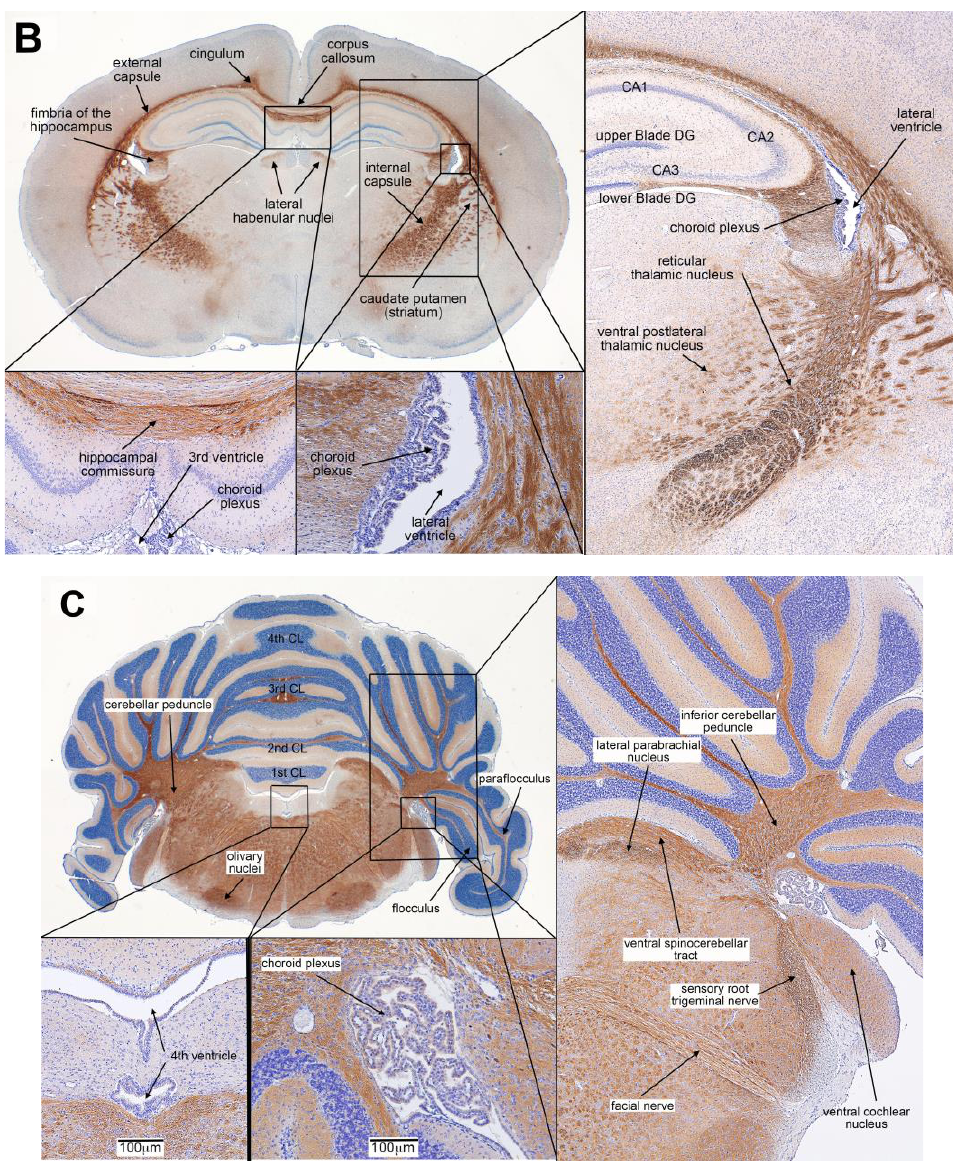
Figure 2. ( A ). Time course of Biotin-PGA uptake and distribution in the PND23 rat brain, immunostained for B-PGA (brown) and hematoxylin (blue/purple). ( B ). Regional distribution of B-PGA in the PND23 cerebrum at 30 min. Extensive accumulation of folate is seen in the white matter tracts, immunostained for B-PGA and hematoxylin. (Abbreviations: CA1; cornu ammonis 1, CA2; cornu ammonis 2, CA3; cornu ammonis 3, DG; dentate gyrus.). ( C ). Regional distribution of B-PGA in the PND23 cerebellum at 30 min, immunostained for B-PGA and hematoxylin. (Abbreviation: CL; Cerebellar lobule).